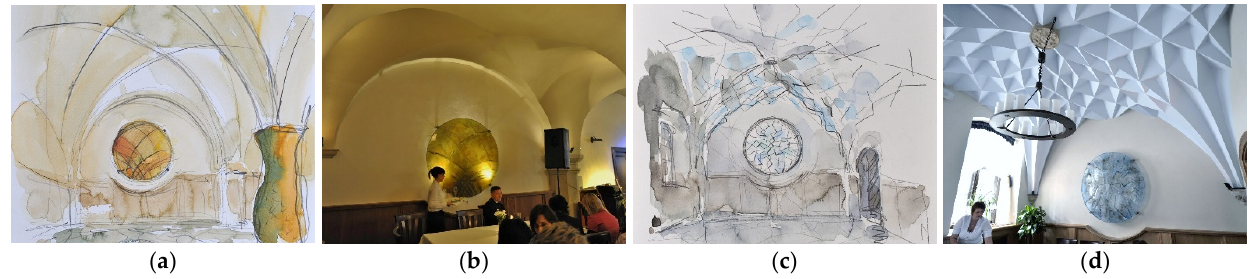
Figure 8. Architectural glass art compositions by Tomasz Urbanowicz inspired by vaults in the corresponding rooms of the cellar in the town hall in Głogów, Poland, 2009: ( a ) a watercolor design for a groin vault room; ( b ) glass-art result with a relief and warm tones related to the interior; ( c ) a watercolor design for a diamond vault room; ( d ) glass-art result with a relief and cold tones related to the interior (Tomasz Urbanowicz).